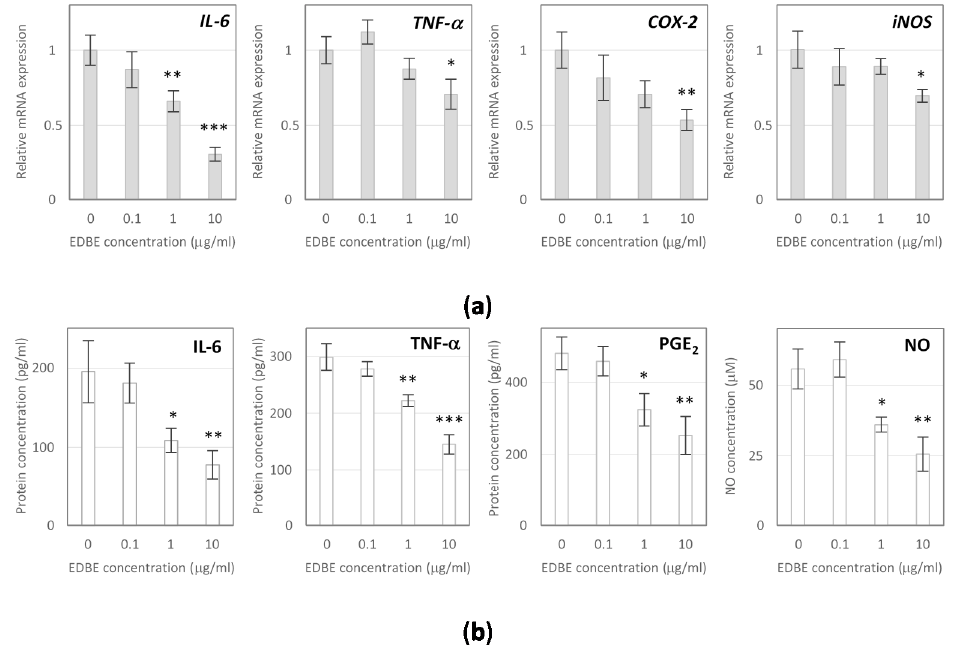
Figure 5. E ff ect of the elderberry fruit extract (EDBE) on mRNA expression of IL-6 , TNF- α , COX-2, and iNOS ( a ) and on the production of IL-6, TNF- α , PGE 2 protein, and NO ( b ) in the lipopolysaccharide (LPS)-activated RAW 264.7 macrophages. Data are mean values ± SD ( n = 3). * p < 0.05, ** p < 0.01, *** p < 0.001 when compared with control.